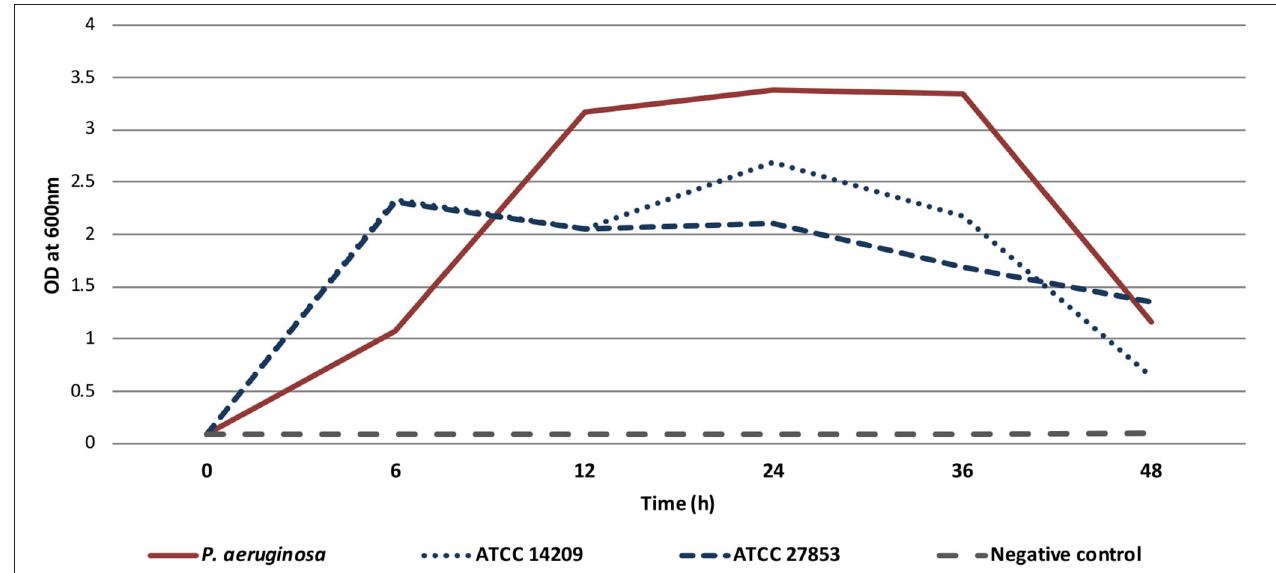
FIGURE 2 | Timeline showing surgical interventions, relevant antimicrobial therapy, and microbiological and pathology